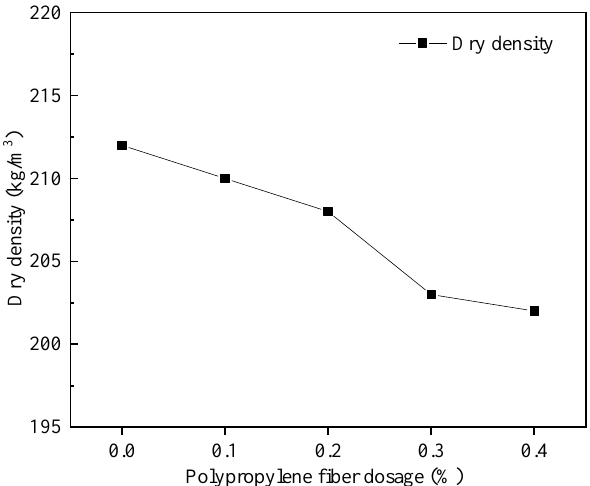
Figure 3. Relationship between dry density and fiber dosage.